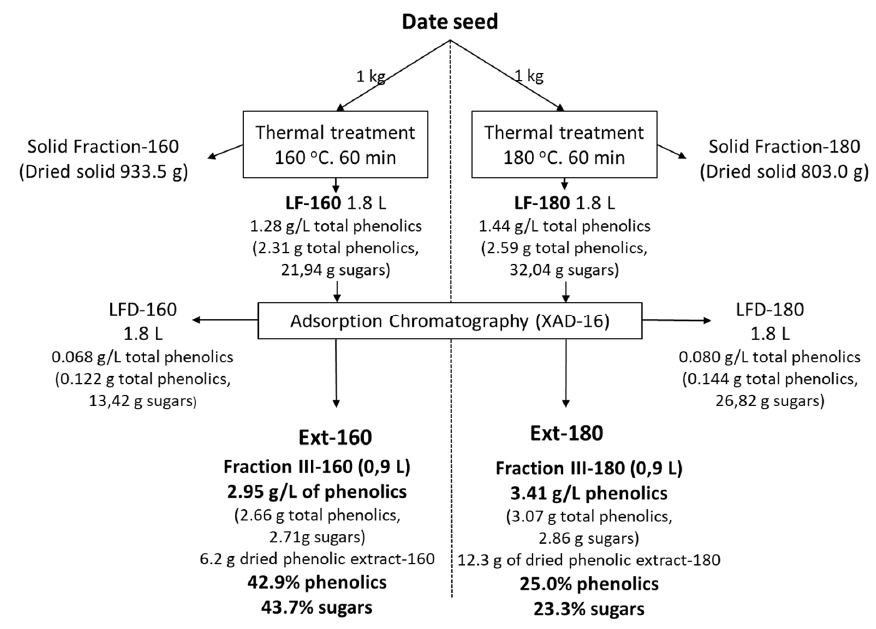
Figure 2. Balance of matter of the thermal treatment extraction and the chromatographic purification, based on one kilogram of seeds.